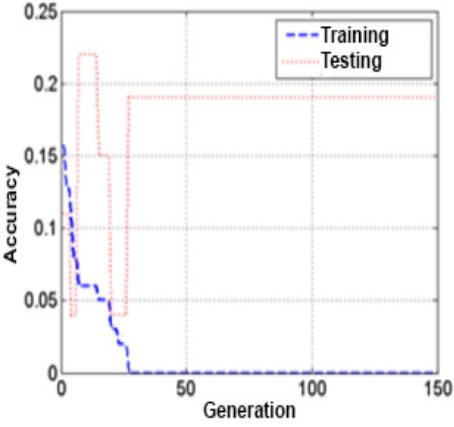
Figure 4. Result of the objective function cryotherapy problem